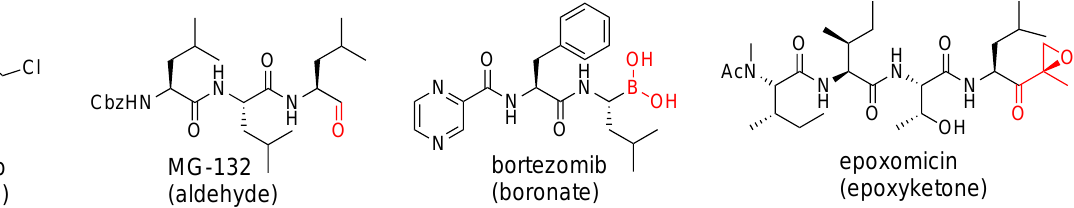
Figure 2. Common proteasome inhibitors. Electrophylic groups reacting with proteasome catalytic threonine are shown in red. Cbz, benzyloxycarbonyl; Ac, acetyl. Proteasomes are present in all eukaryotes, archaebacteria, and mycobacteria, includ- ing Mycobacterium tuberculosis . Due to their essential role in the pathogenesis of M. tuber- culosis and several eukaryotic parasites, e.g., Plasmodia, Leishmania, and Trypanosoma, proteasomes are considered drug targets for the treatment of tuberculosis, malaria, leish- maniasis, African sleeping sickness, and Chagas disease. A comprehensive review of se- lective inhibitors of mycobacterial and parasitic proteasomes has just been published [29], and this review will therefore focus on the inhibitors of mammalian proteasomes.